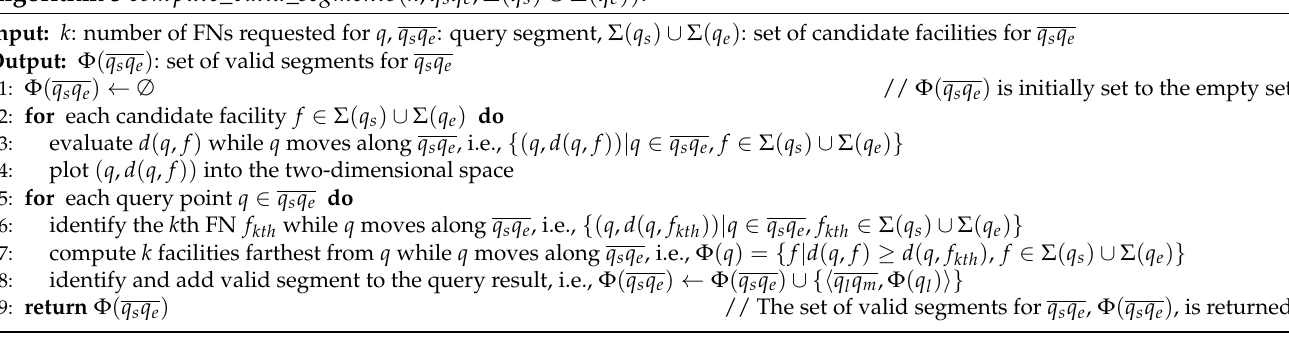
Algorithm 3 compute _ valid _ segments ( k , q s q e , Σ ( q s ) ∪ Σ ( q e ))